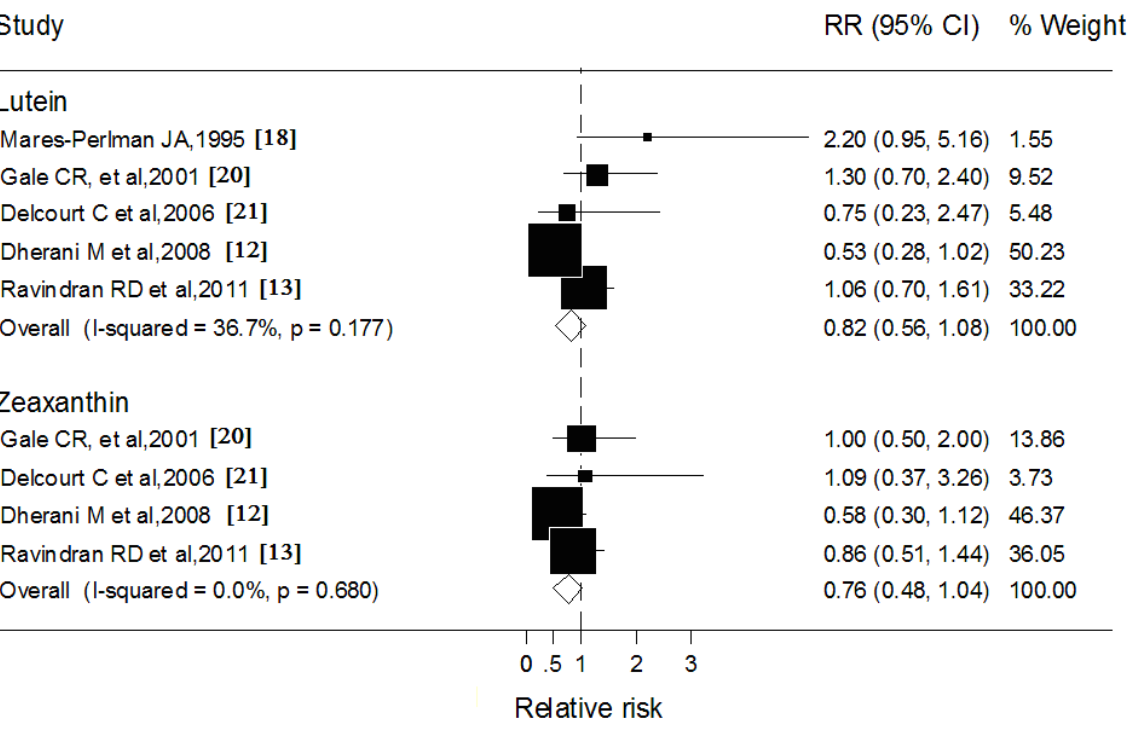
Figure 3. Forest plots of relative risks (RR) and 95% confidence interval (CI) for highest- versus -lowest category of blood concentrations of lutein and zeaxanthin